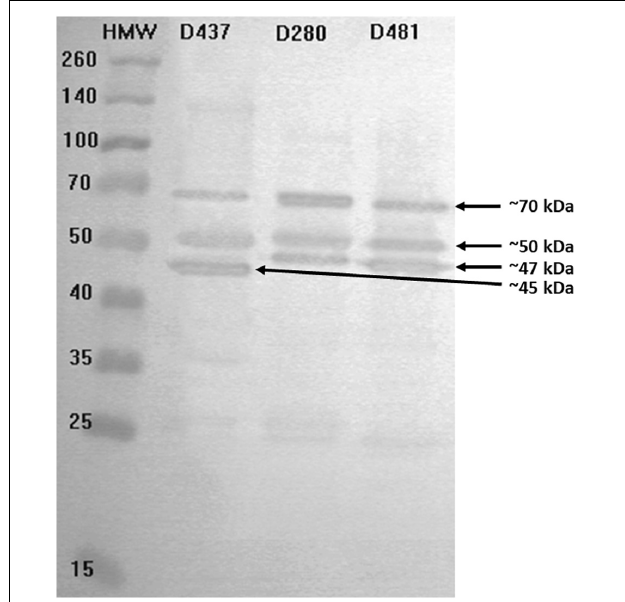
FIGURE 6 | Exemplary results for immunoblotting of proteins from chosen GBS strains (strains no. D437, D280, D481) originating from UTI with visible protein bands by molecular weight 45, 47, 50, and 70 kDa. Immunoreactivity was studied in the presence of serum sample no. PP9 isolated from a